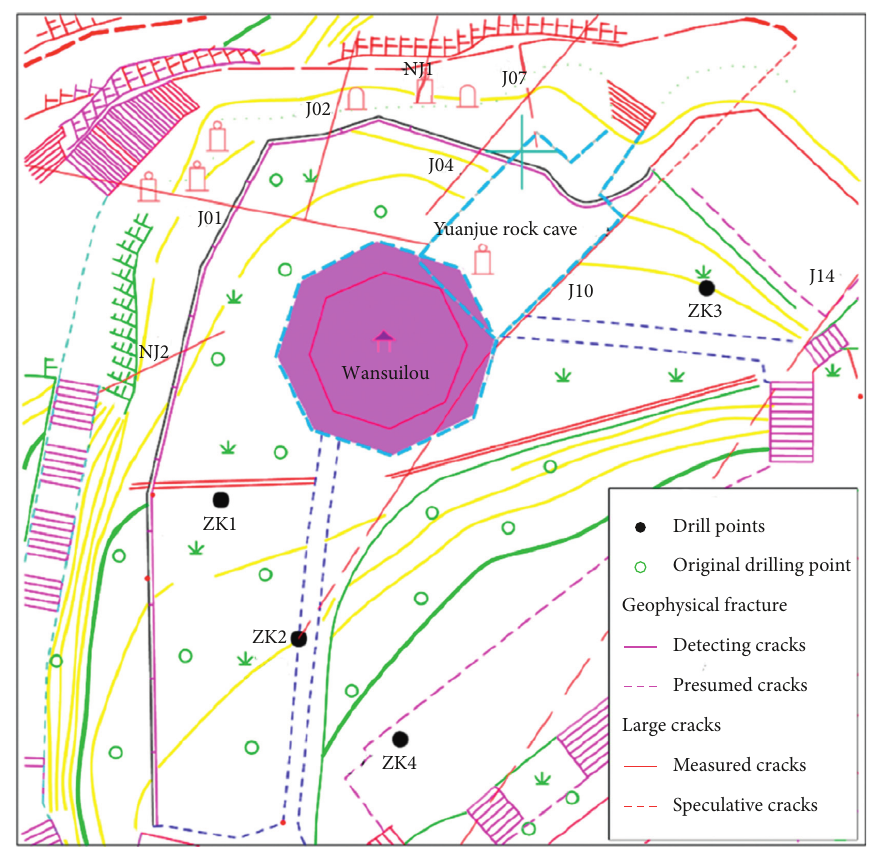
Figure 1: Distribution of fissures of Yuanjue rock cave within